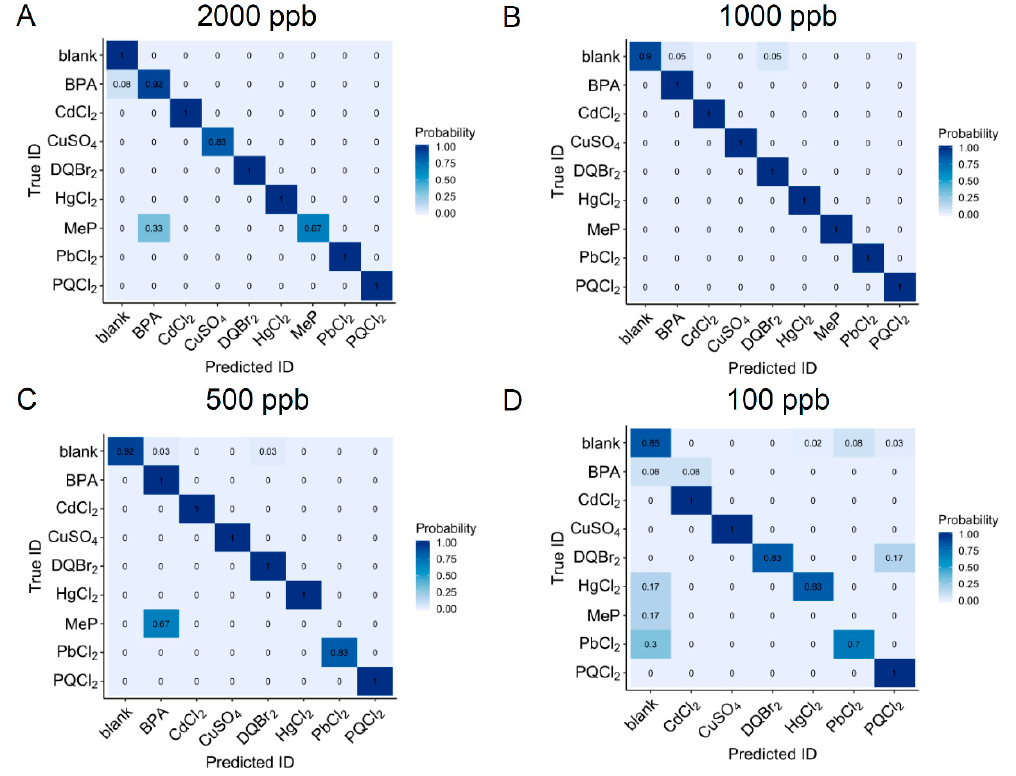
Figure 6. The confusion matrix at each concentration. ( A ) 2000 ppb, ( B ) 1000 ppb, ( C ) 500 ppb, and ( D ) 100 ppb.